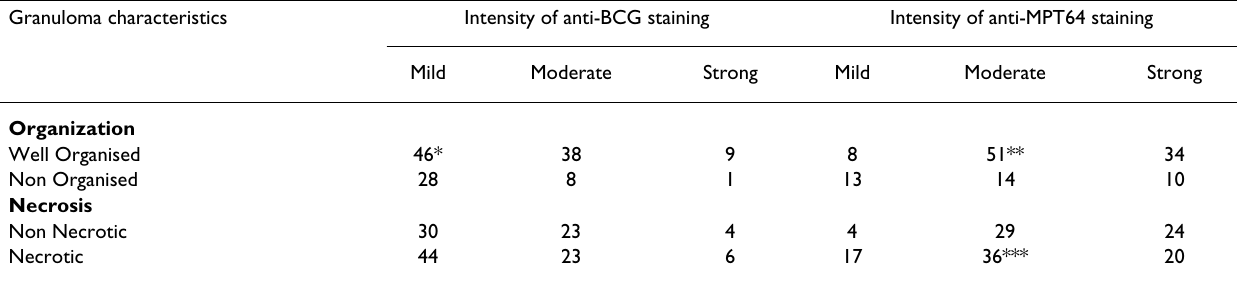
Table 3: Intensity of immunohistochemical staining by two antibodies in relation to granuloma features. Granuloma characteristics